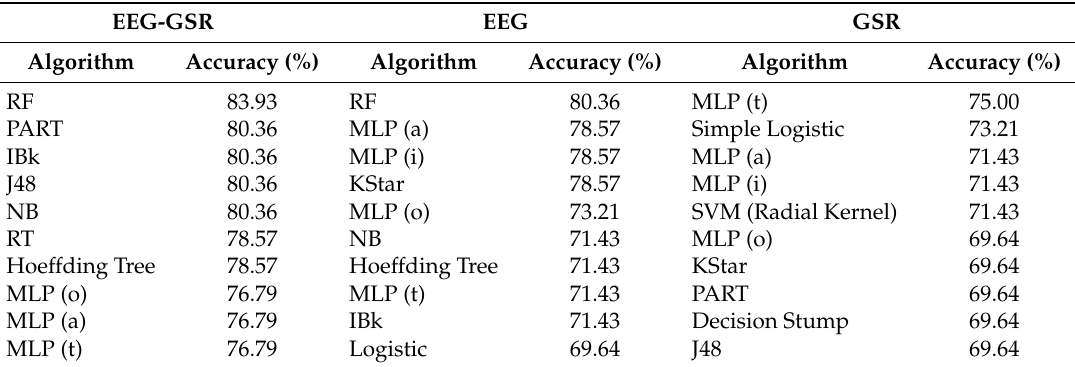
Table 4. Initial testing results for model